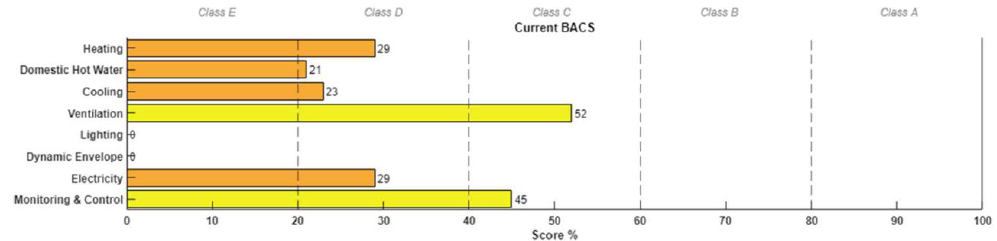
Figure 5. BACS auditing results for case study A along with domains assessment classes.